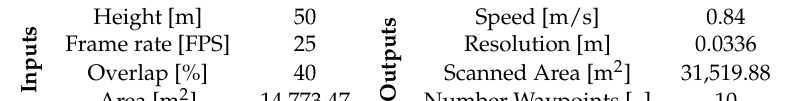
Table 3. Waypoint mission setup.